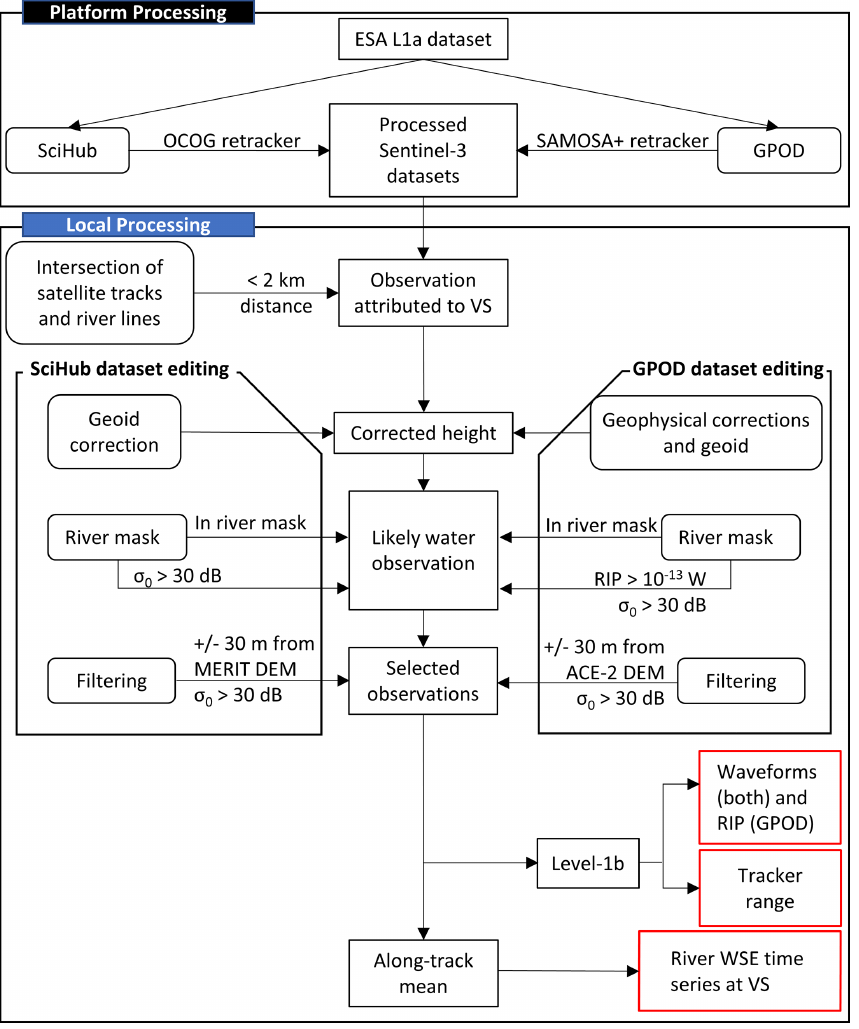
Figure 2. Outline of the processing workflow applied in this study to obtain water surface elevation (WSE) time series and waveform statistics. The differences between the two datasets are highlighted left (SciHub) and right